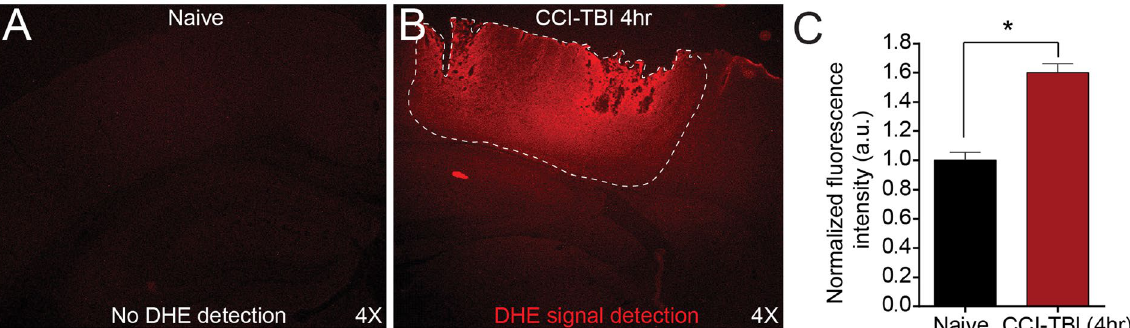
Figure 2. CCI-TBI induces ROS free radical production in ipsilateral cortex area of injury. In vivo dihydroethidium staining detection in naive ( A ) vs. 4 hrs following CCI-TBI ( B ) cerebral cortex in area of CCI-TBI impact site (4X). Red fluorescence indicates oxidation of dihydroethidium and in situ ROS free radical detection. The impact site and affected ipsilateral cortical tissue is outlined with a white dotted line. ROS detection extends through and beyond the depth of the cortex. ( C ) Quantification of dihydroethidium fluorescence intensity in naive compared to CCI-TBI groups at 4 hrs post-injury. Data are presented as mean ± SD. (Two-tailed unpaired t test with equal SD P = 0.0002, t = 12.83, df =